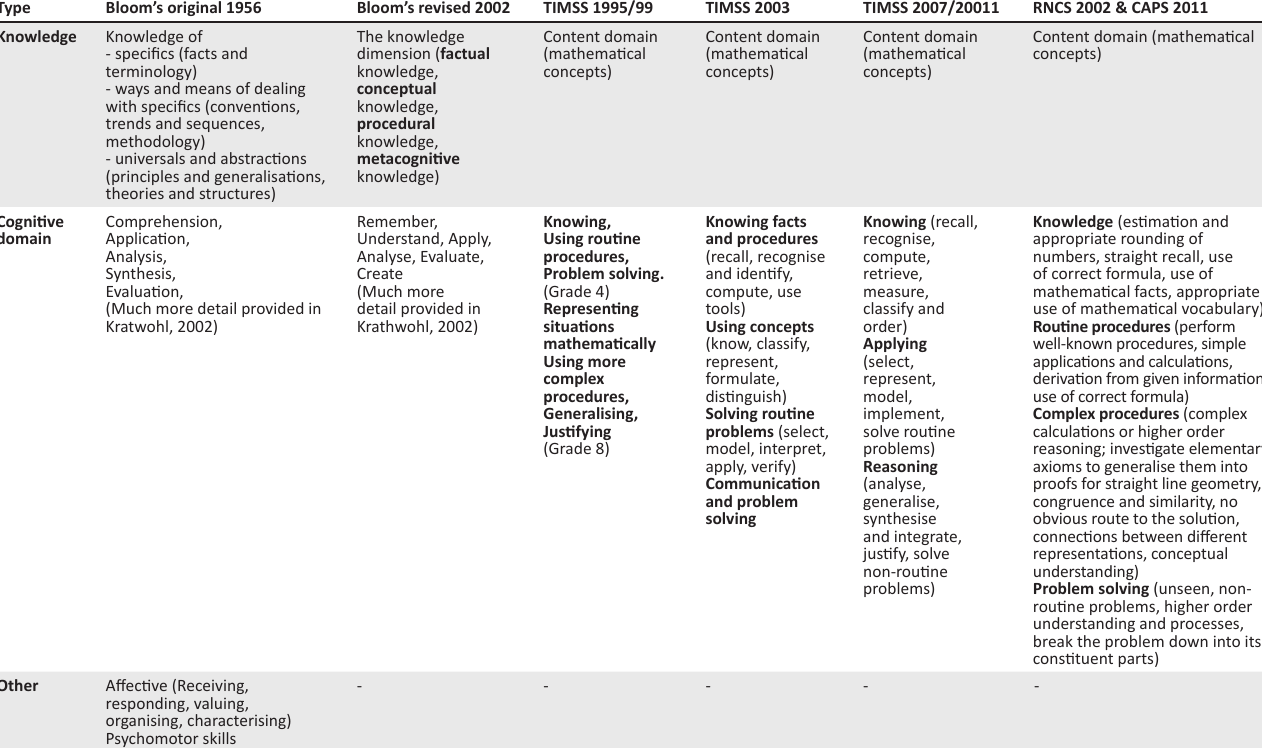
TABLE 2: Conceptual and cognitive domains: Bloom’s (original and revised), TIMSS 1995/1999, 2003, 2007/2011, RNCS and